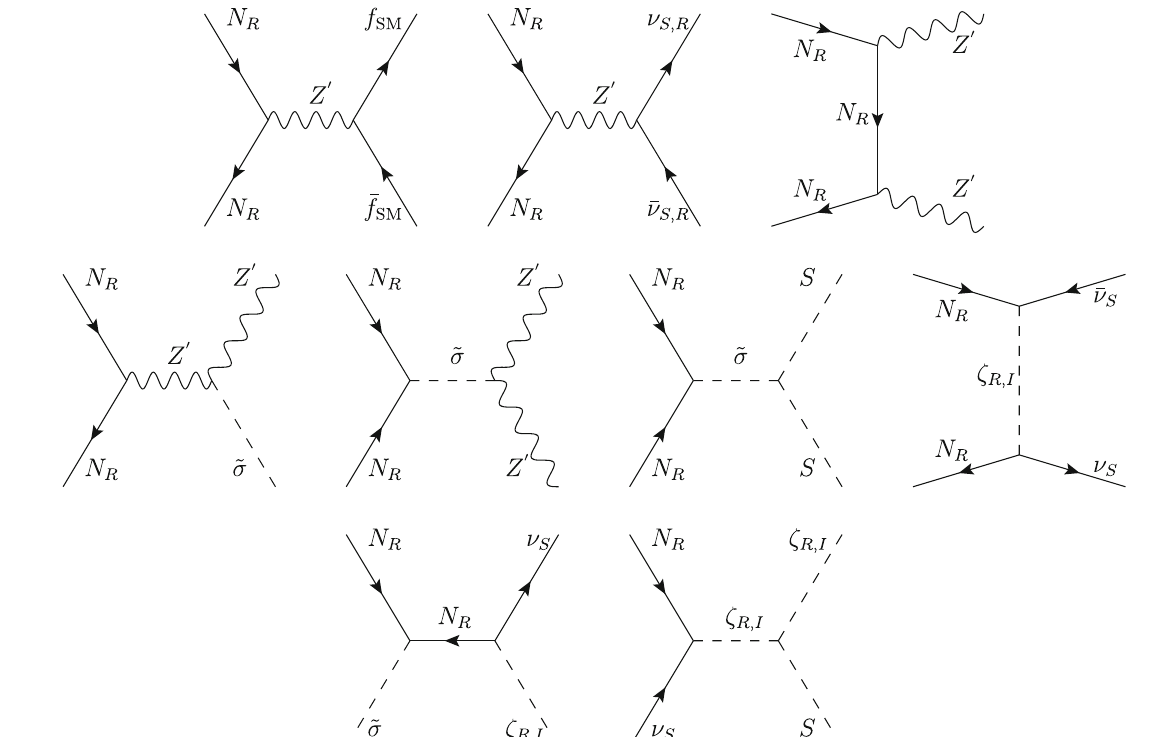
Fig. 4 Main channels contributing to the production of fermionic DM. f SM indicates all the SM fermions coupled to the Z (cid:2) and S = h , ˜ σ , ˜ χ , and ζ R , I